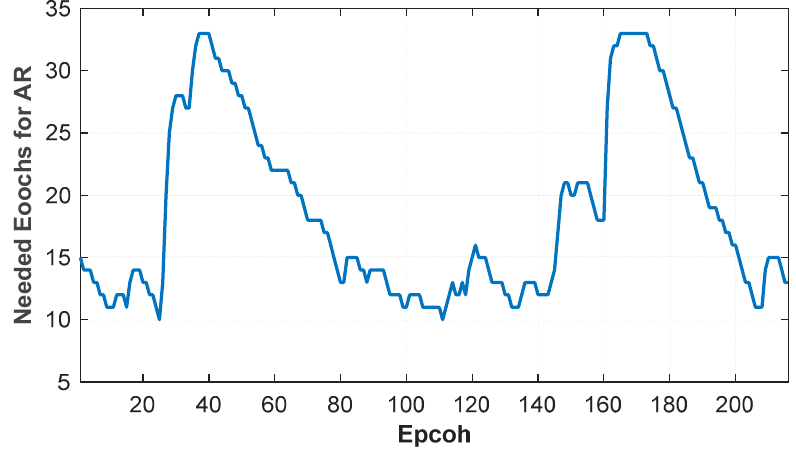
Figure 13. Epochs needed for reliable AR (ambiguity resolutions) during the round trip.